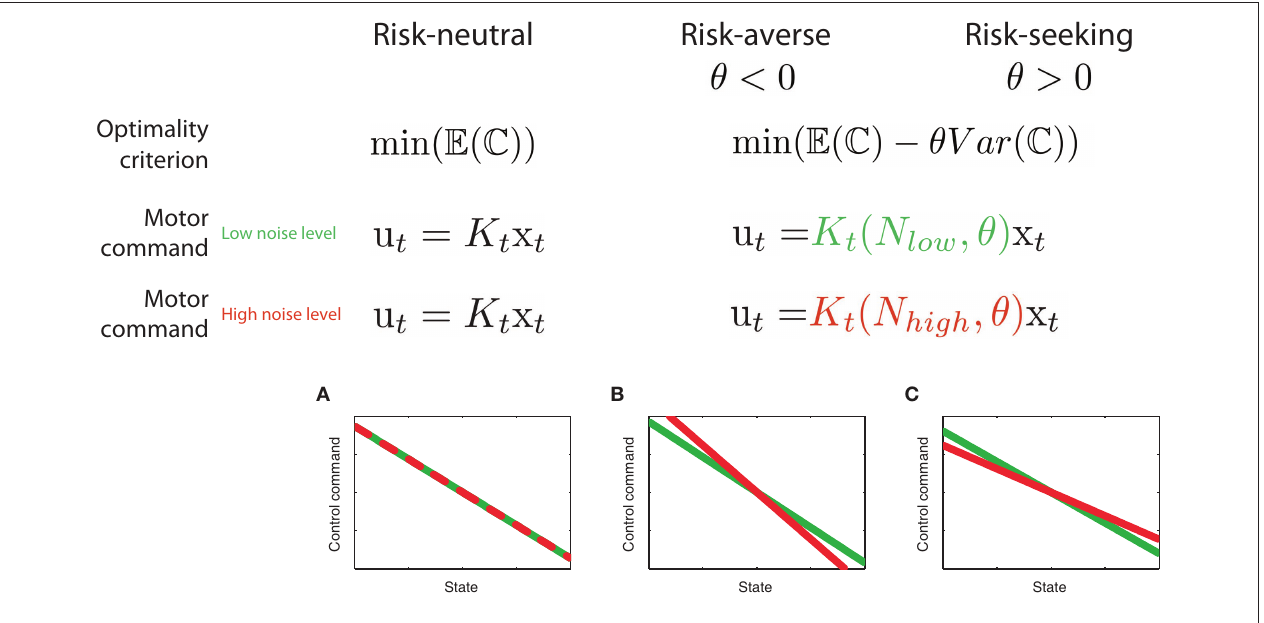
Figure 3 | Predictions of risk-sensitive optimal feedback control. A risk-neutral optimal control model ( θ = 0) attempts to minimize the mean of the cost function. As a result, its policy (that is the motor command applied for a given state of the world) is independent of the noise variance N . In contrast, a risk-sensitive optimal control model minimizes a weighted combination of the mean and variance of the cost. Additional variance is an added cost for a risk-averse controller ( θ < 0), whereas it makes a movement strategy more desirable for a risk-seeking controller ( θ > 0). As a